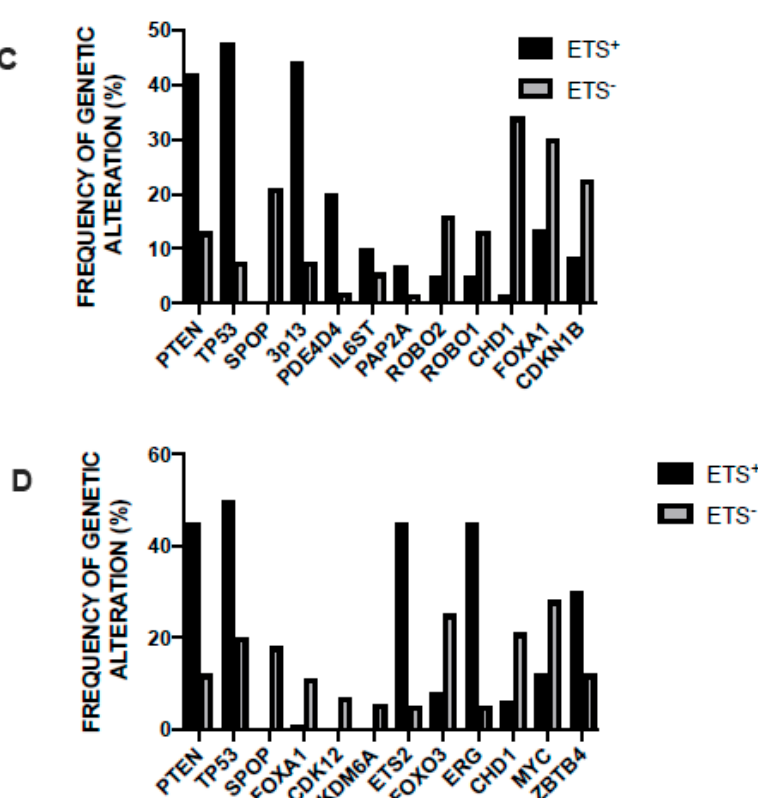
Figure 1. ( A ) Comparison of the main genetic alterations (copy number alterations and mutations) observed in primary and metastatic prostate cancer. The data are reported in the study of the Cancer Genome Atlas Project (TCGA) [38]. ( B ) Comparison of the alterations in signaling and biochemical pathways observed in primary and metastatic prostate cancer. The data are reported in Armenia et al. [61]. ( C ) Common genomic alterations observed in prostate cancer (mostly primary cancers) patients subdivided according to the presence of ERG gene fusions into ETS + and ETS - . The data are reported in Wedge et al. 2018 [65]. ( D ) Common genomic alterations observed in primary prostate cancer patients subdivided into ETS + and ETS - groups according to the presence of ETS gene fusions. Data are reported in Xiao et al., 2018 [66].